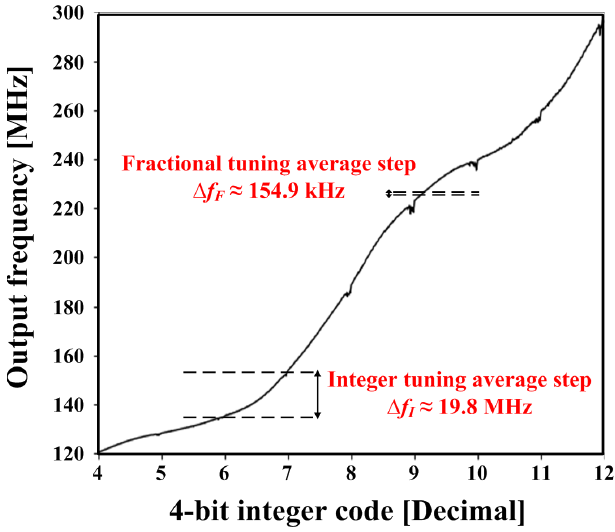
Figure 8. Measured ring-DCO tuning